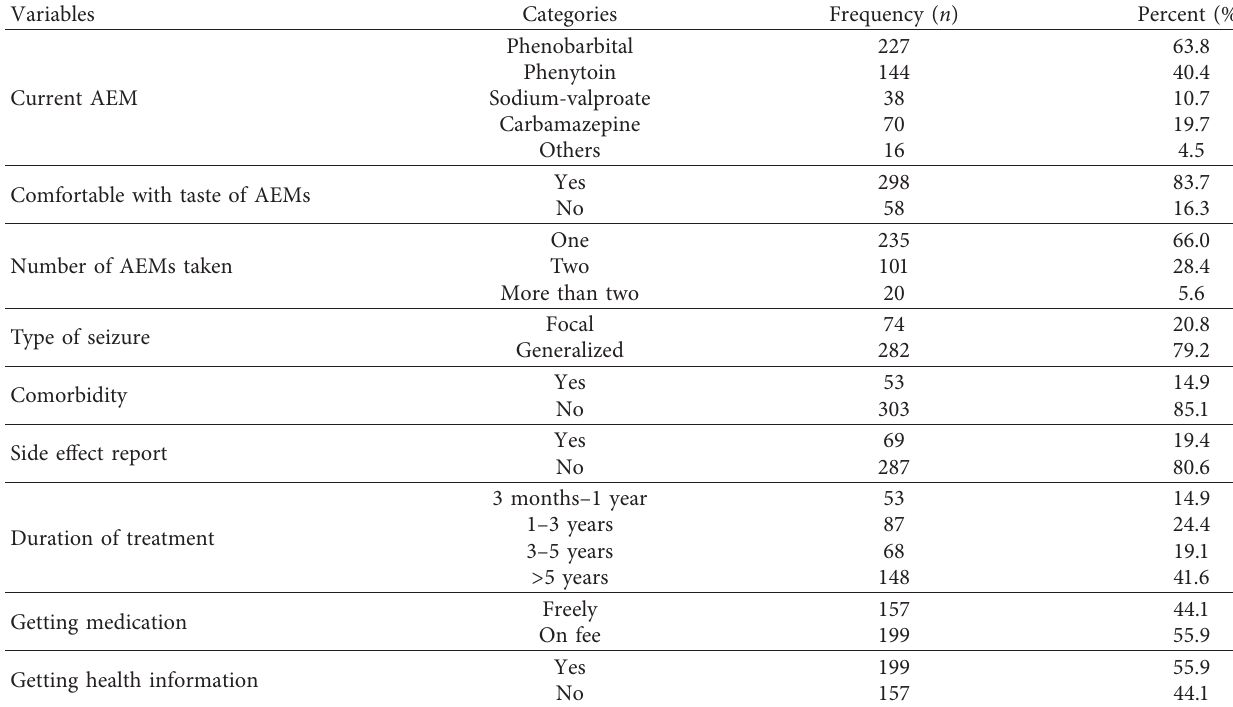
Table 2: Distribution of epileptic patients by clinical and treatment-related factors at UGCSH, Ethiopia, 2019 ( n � 356). Variables